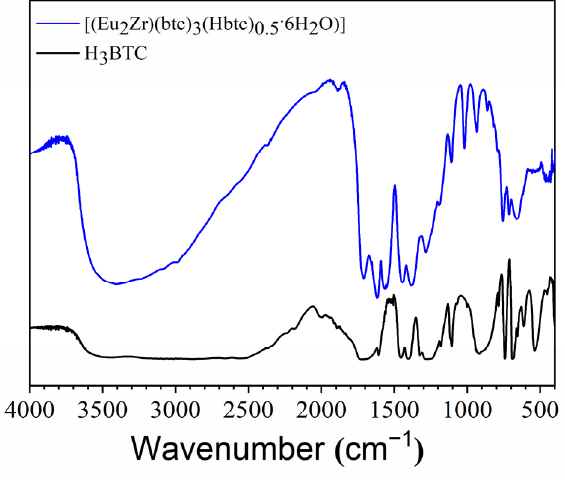
Figure 2. Infrared Spectra for [(Eu 2 Zr)(btc) 3 (Hbtc) 0 . 5 ·6H 2 O)] compound and for the benzenetricar- boxylic acid (H 3 btc) precursor.